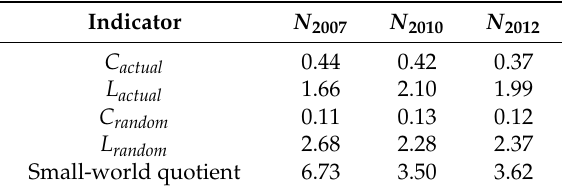
Table 3. Small-world quotients in each